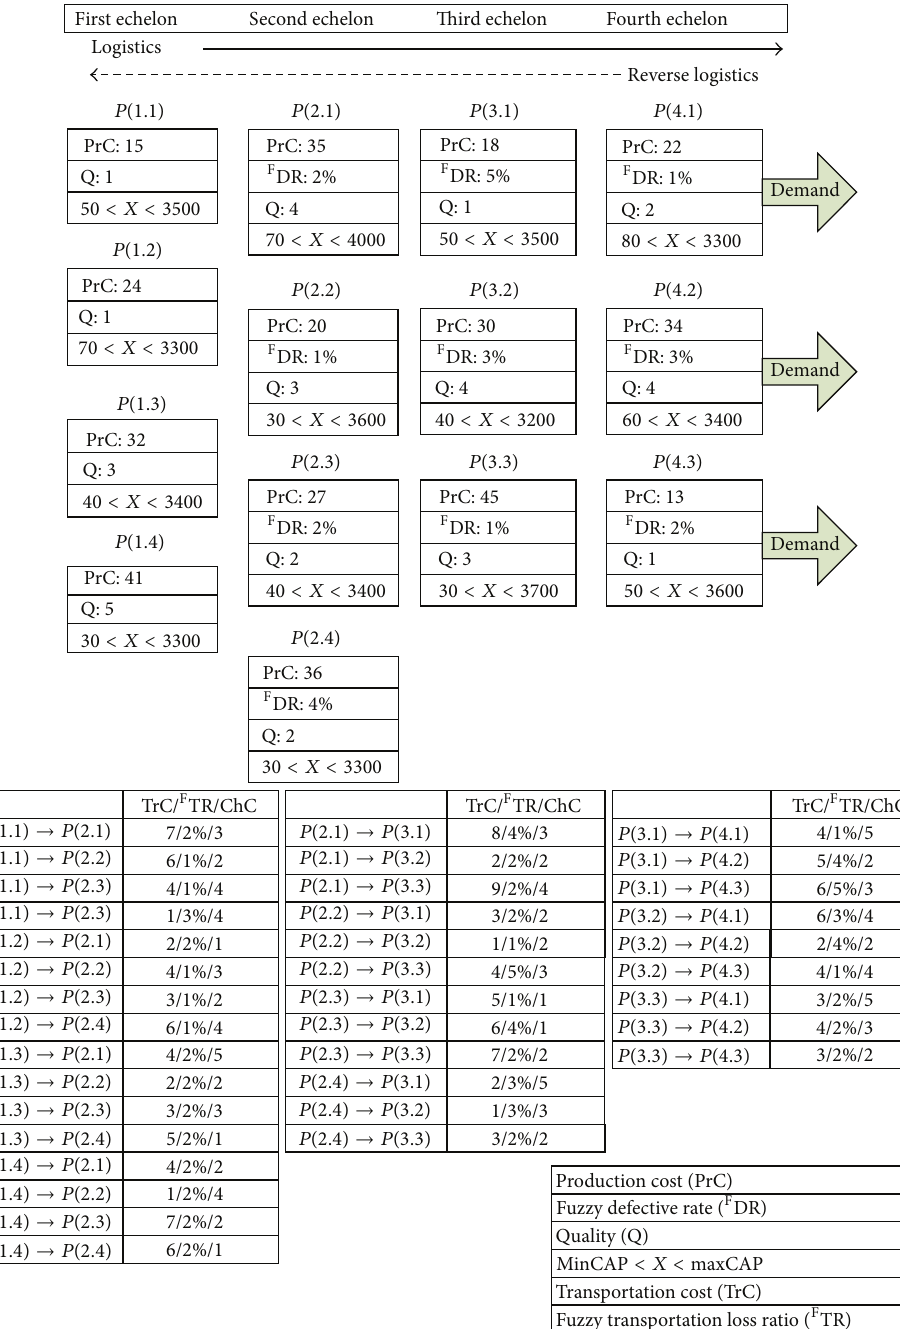
Figure 5: { 4-4-3-3 } reverse supply chain network.